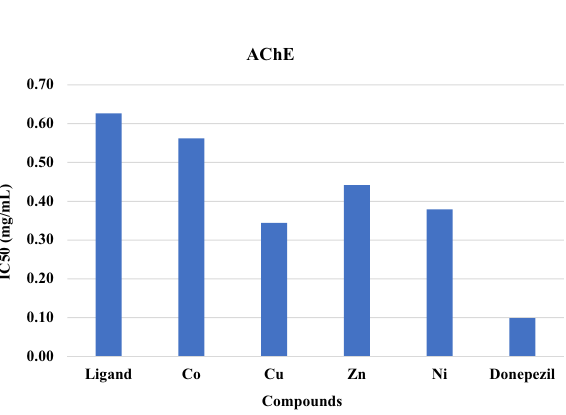
Figure 11. RBC IC50 values for the standard (donepzil), ligand and its metal